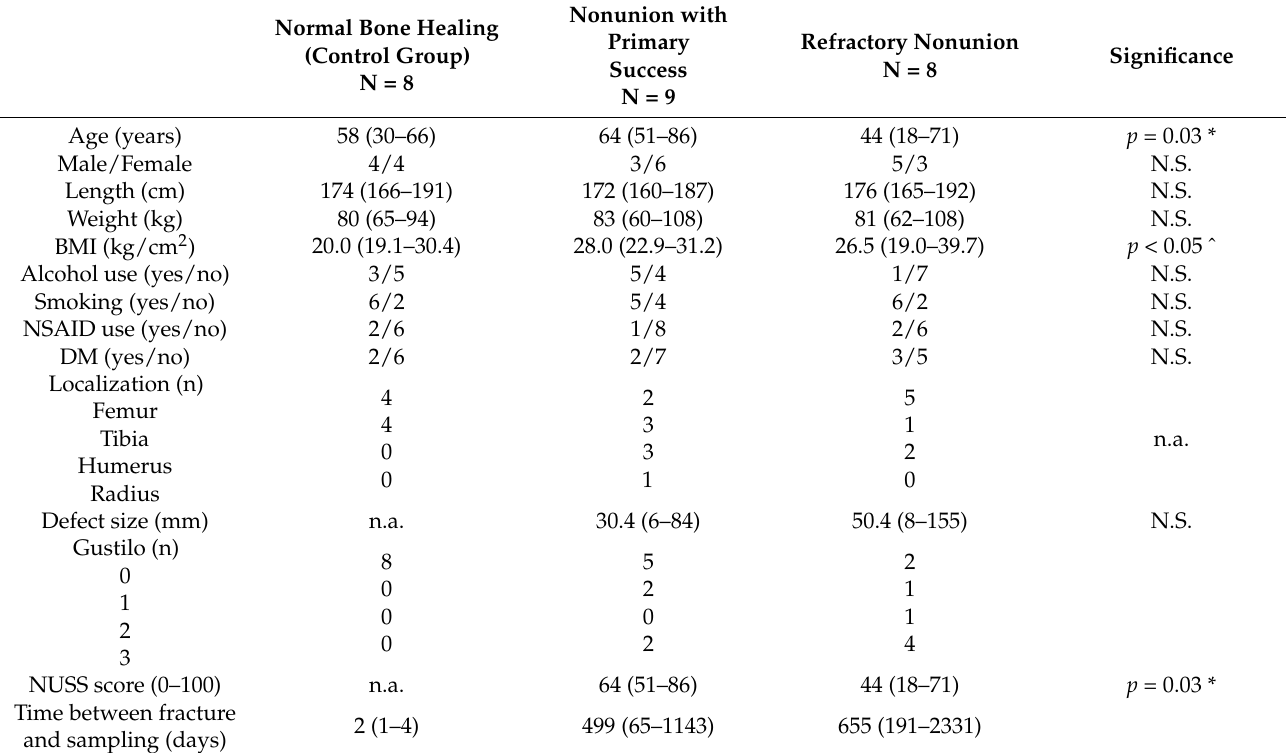
Table 1. Patient